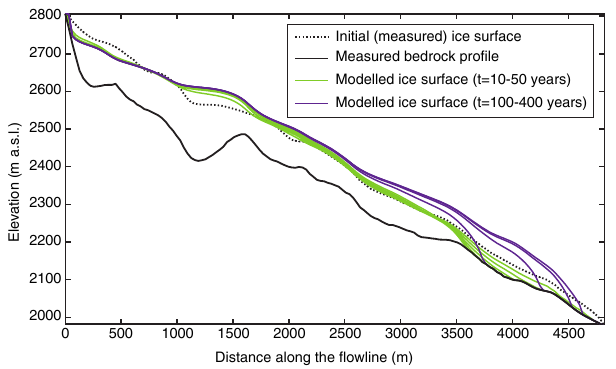
Fig. 9. Simulated glacier profile evolution in response to zero net balance applied to the original profile. The structure of the bal- ance profile follows the dashed curve in Fig. 3 and remains spa- tially fixed throughout the simulation. Glacier retreat is shown at 10-yr intervals from 10–50modelyr (green), and glacier ad- vance at 100-yr intervals from 100–400modelyr (purple). A = 2 . 4 × 10 − 24 Pa − 3 s − 1 , m max = 0 . 5 and λ max = 13 . 5m in this sim-